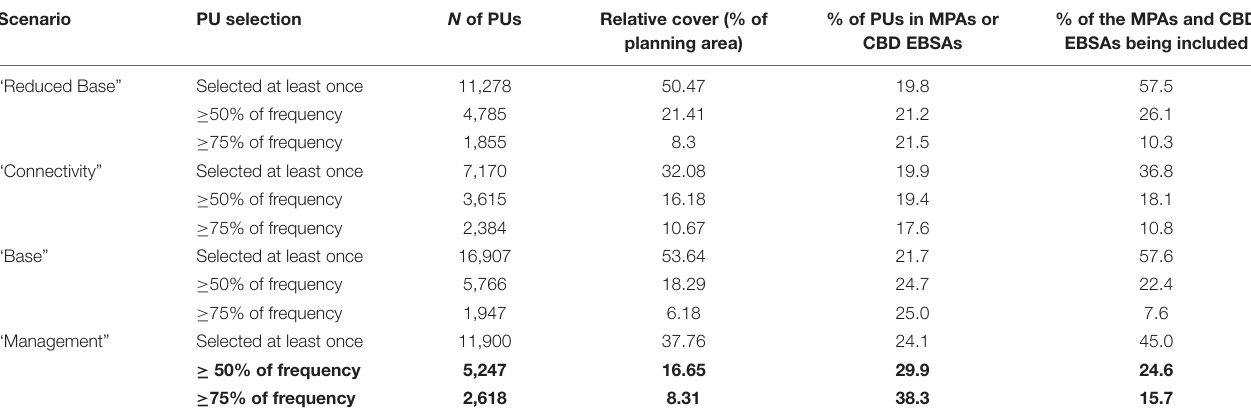
Scenario PU selection N of PUs Relative cover (% of